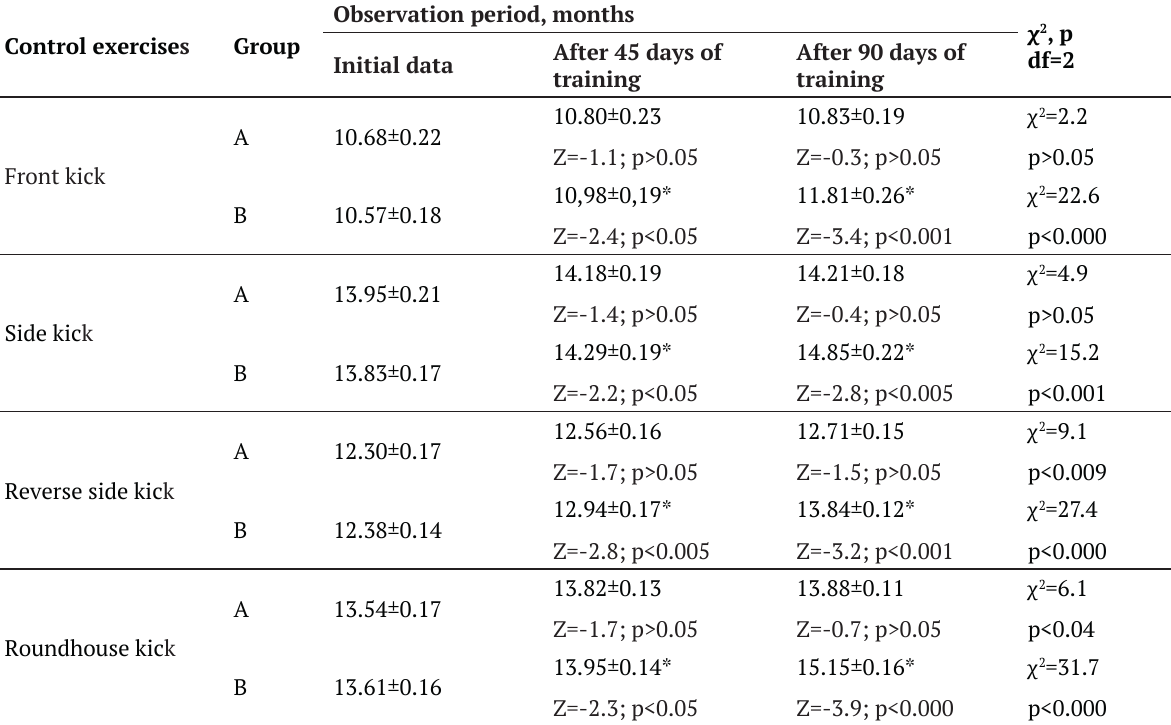
Table 2. The number of accurate kicks on the mannequin for 30 s performed by both group athletes during the study, n = 36 Control